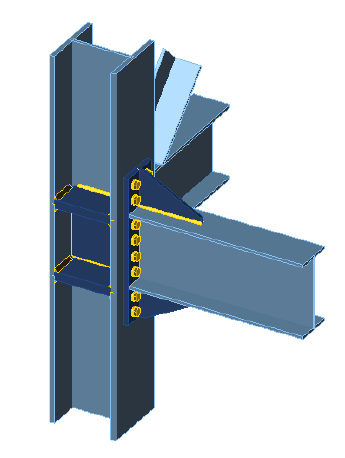
Figure 3. Isometric view of the eight-bolt extended stiffened (8ES) end-plate connection (EPC) fully reinforced (continuity plate-doubler plate-stiffener plate (CP-DP-ST)) connection.